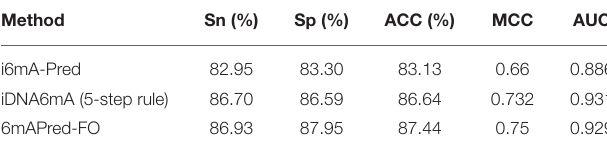
TABLE 2 | Comparison of the proposed 6mAPred-FO with existing